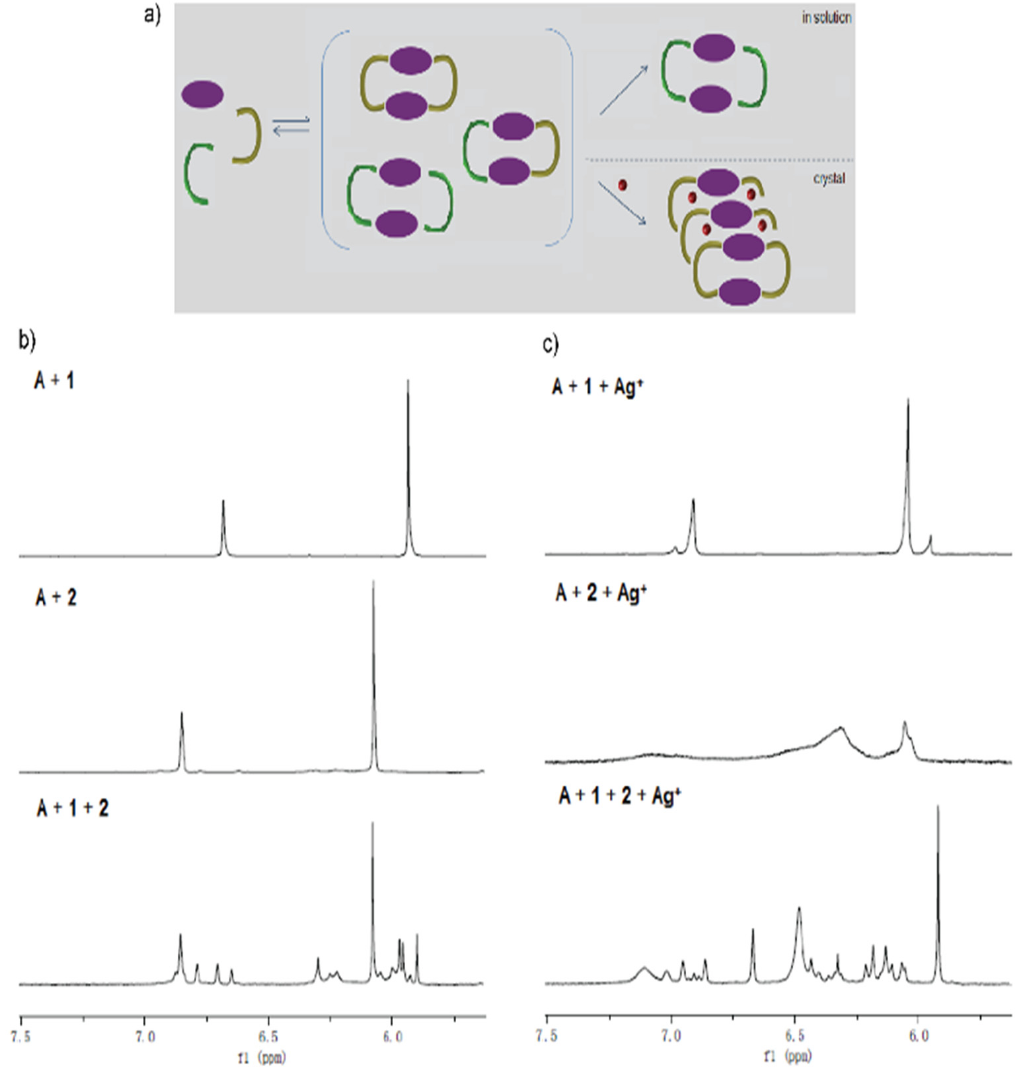
Figure 2. ( a ) Schematic presentation of a selection from the dynamic library L1 containing dialdehyde A and amines 1 and 2 . 1 H-NMR spectra of L1 ( b ) with the absence and ( c ) with the presence of Ag + . Then, a second library L2 containing dialdehyde A , 1,3,5-positioned trialdehyde C ,